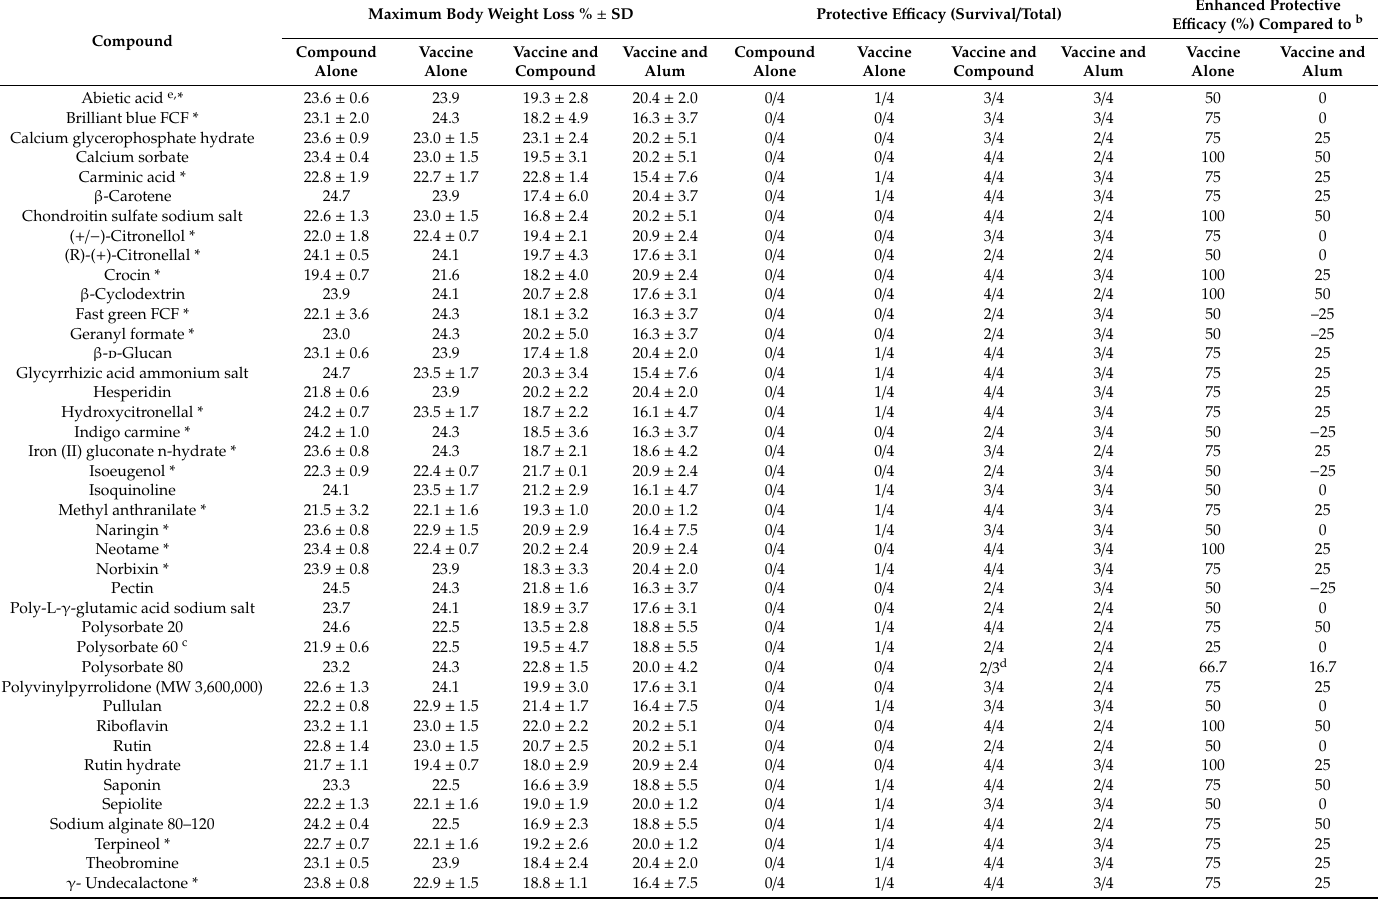
Table 2. Protective e ffi cacy of the 41 hit compounds against lethal challenge of immunized mice a . Maximum Body Weight Loss % ± SD Protective E ffi cacy (Survival / Compound